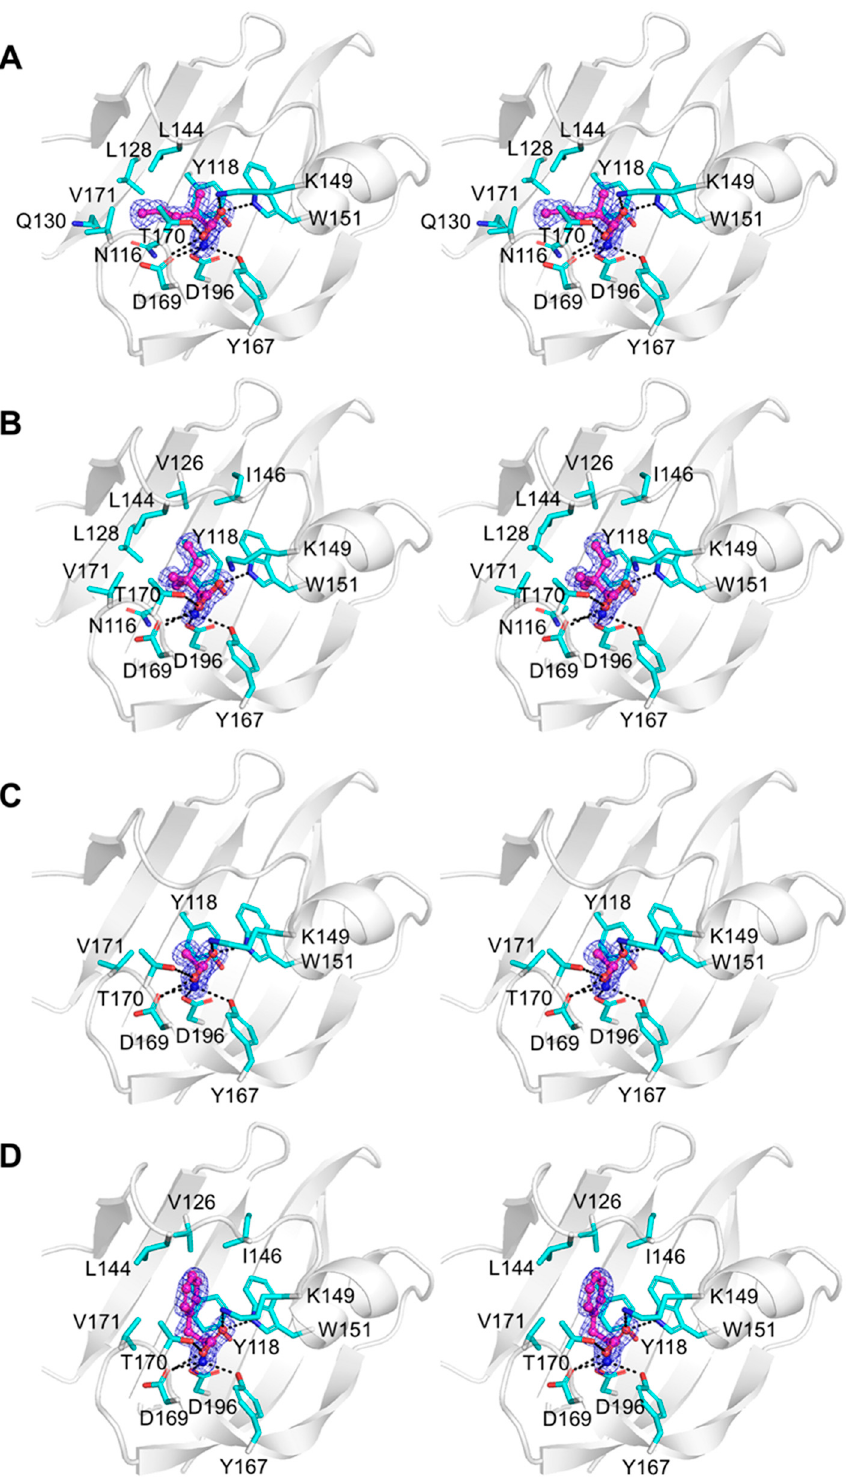
Figure 6. Close-up stereoview showing simulated annealing composite omit electron density for amino acids bound to membrane-distal subdomain of Tlp3 LBD in respective complexes with: ( A ) β -methyl-L-norleucine, ( B ) 3-methyl-L-isoleucine, ( C ) L-alanine, and ( D ) L-phenylalanine. The ligand molecules are shown in all-atom ball-and-stick representation with C atoms coloured purple. The protein side chains that form direct contacts with the ligands are shown in stick representation. The map was contoured at the 1.0 σ level.